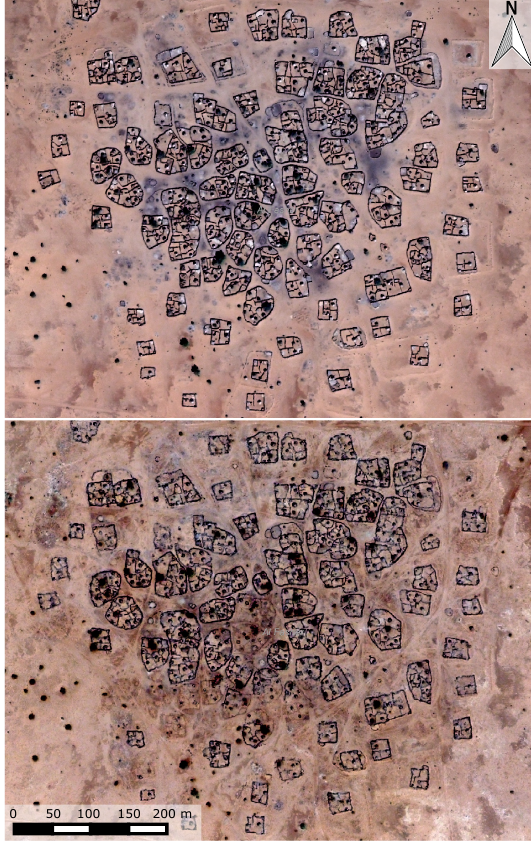
Figure 1. Example image of a village in Darfur (location: 13.686 ◦ N, 24.979 ◦ E) before (December 2004, top) and after (February 2007, bottom) a reported attack. Images c (cid:13) 2016